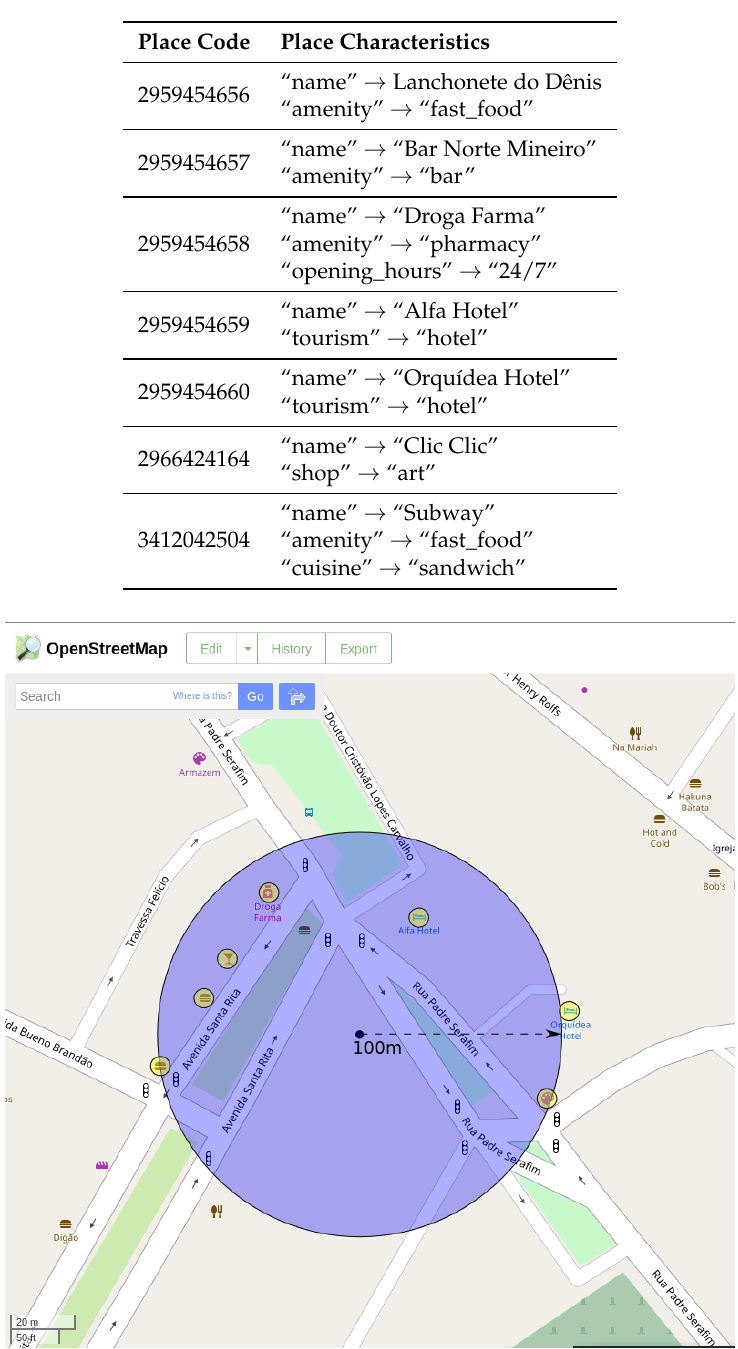
Table 1. Places found within a 100 m radius from the geographic coordinate of a volunteered geographic information (VGI) contribution.